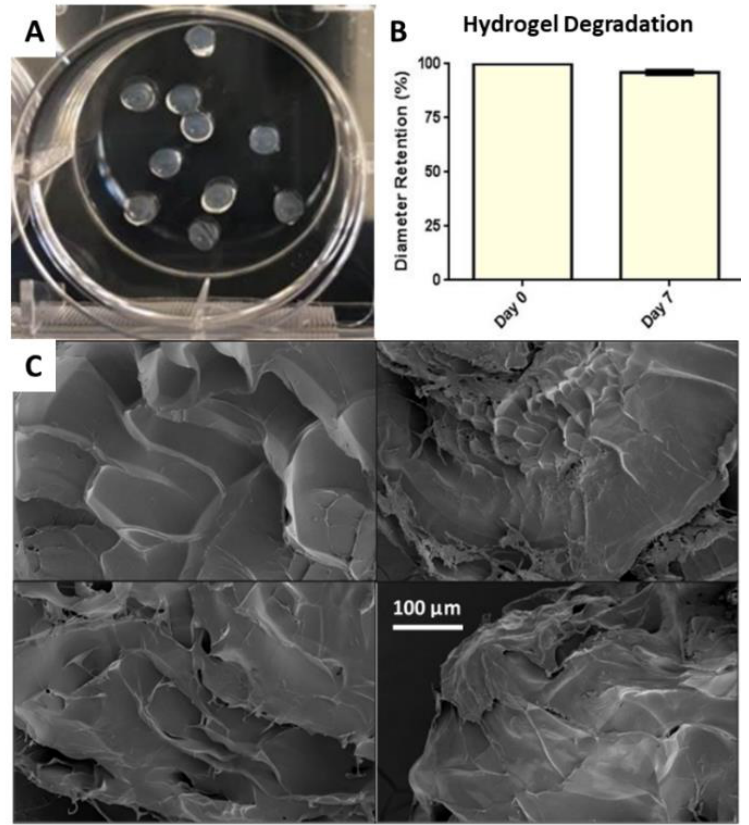
Figure 3. ( A ) Representative image of bioprinted hydrogels post-crosslinking. ( B ) Diameter retention of 3:2 5% alginate 3D hydrogels at Day 0 and Day 7. ( C ) Scanning electron microscopy images show the rough surface of the printed structures with minimal porosity.